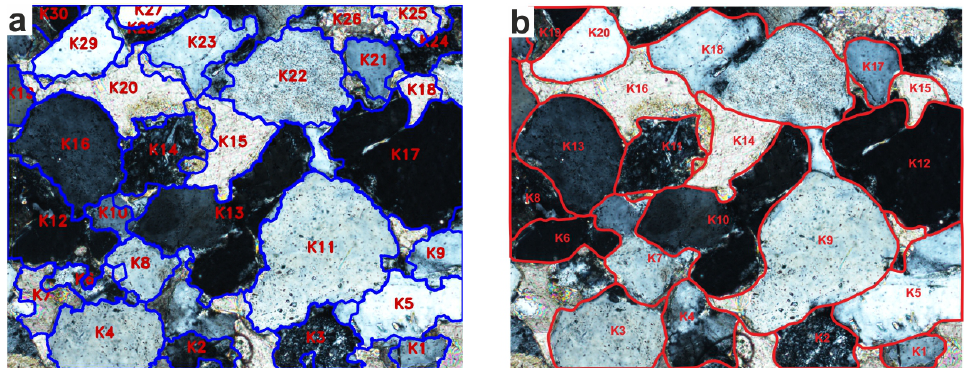
Figure 13. Subdivision of the thin section image into areas: ( a ) 30 areas (minerals), ( b ) 20 areas